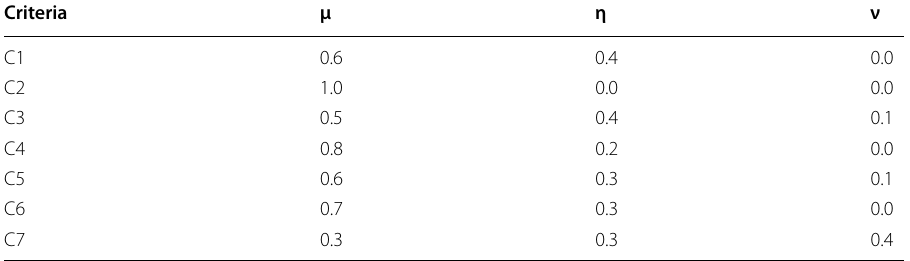
Table 5 PF criteria matrix for weight calculation Criteria